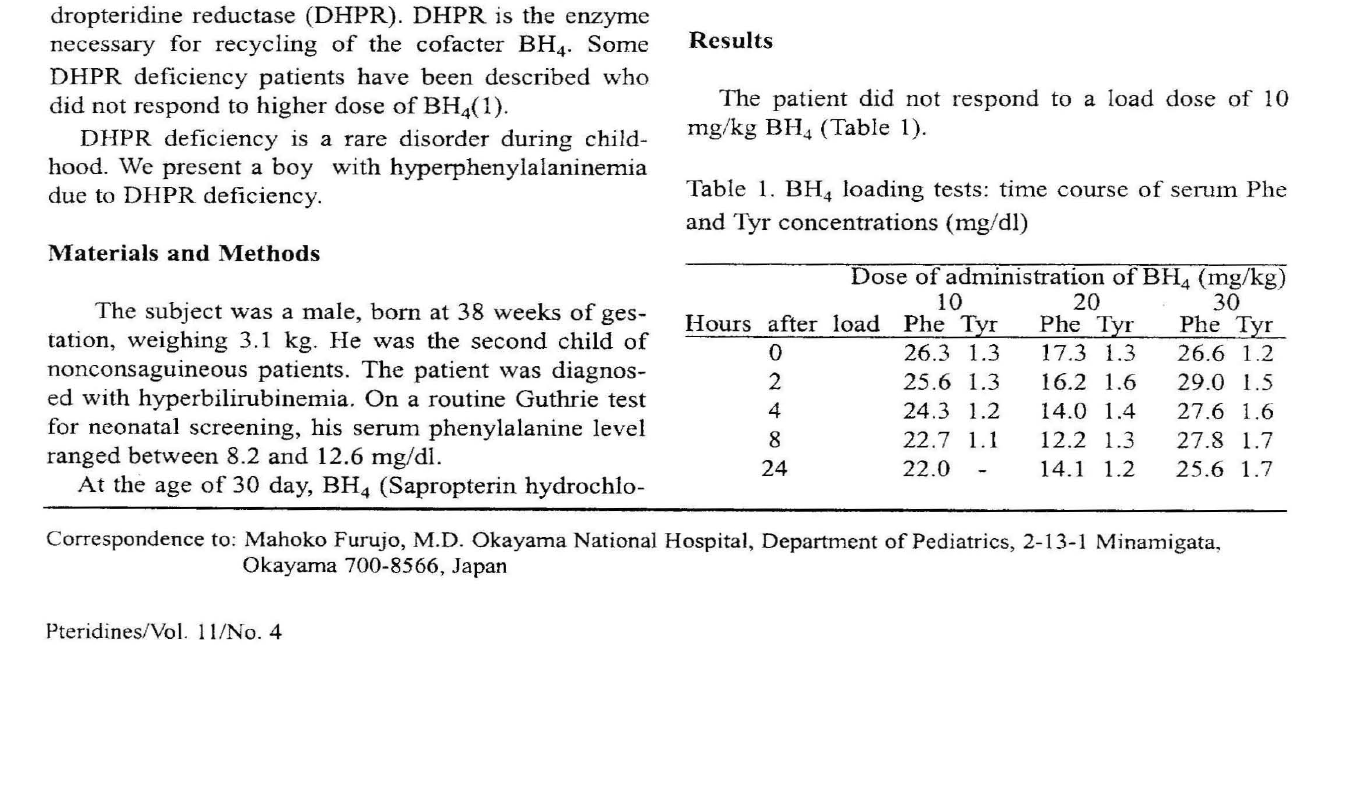
Table 1. BH4 loading tests: time course of serum Phe and Tyr concentrations